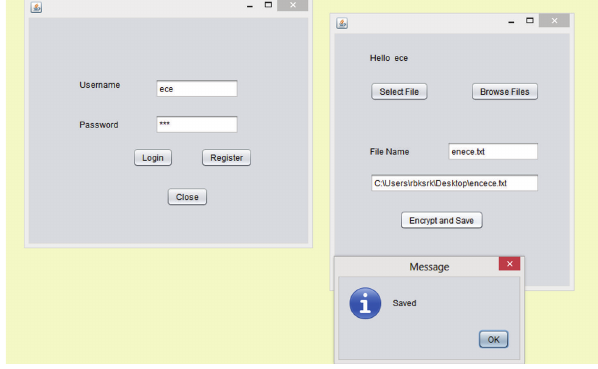
Figure 8: Encryption.